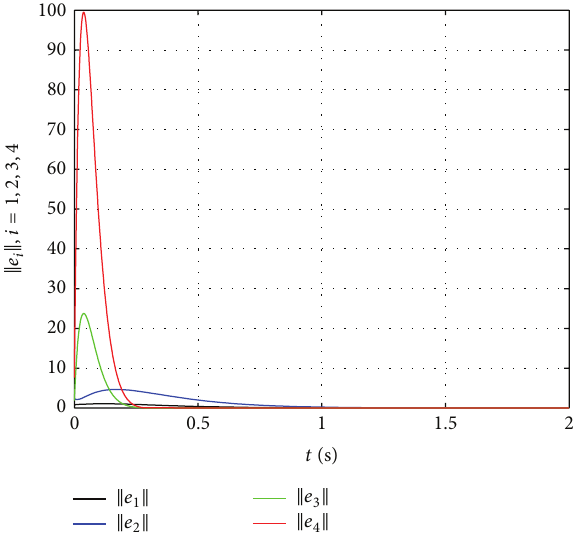
Figure 3: Consensus tracking for the second-order nonlinear systems.